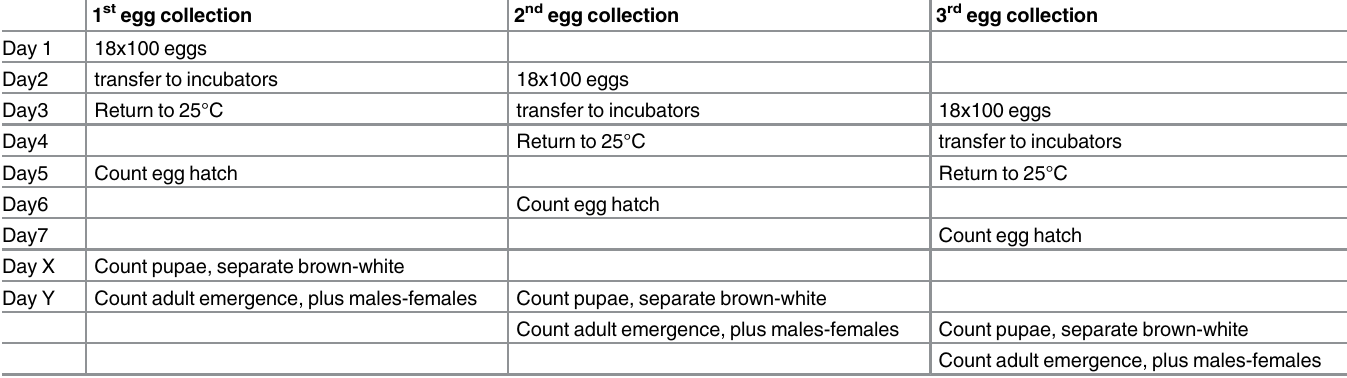
Table 2. Summary of the protocol used for the tsl screening and Quality Control analysis of the medfly Vienna 8 GSS. 1 st egg